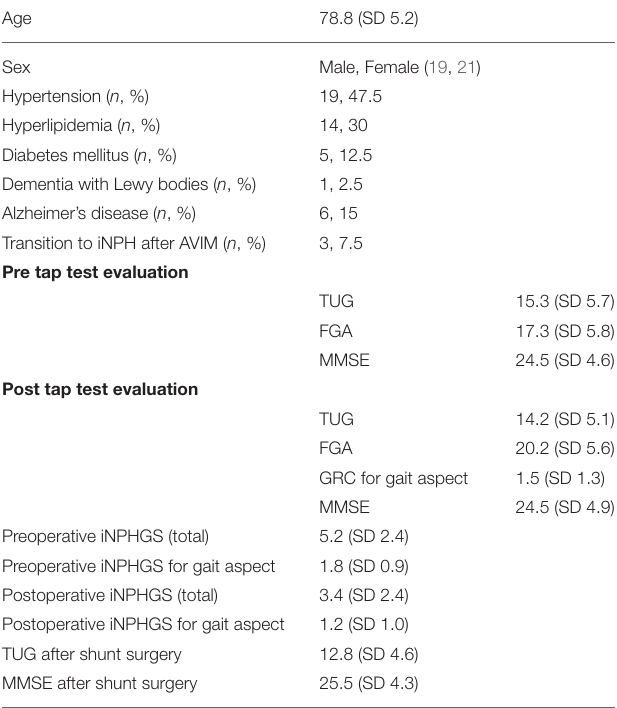
TABLE 1 | Patient characteristics ( n =